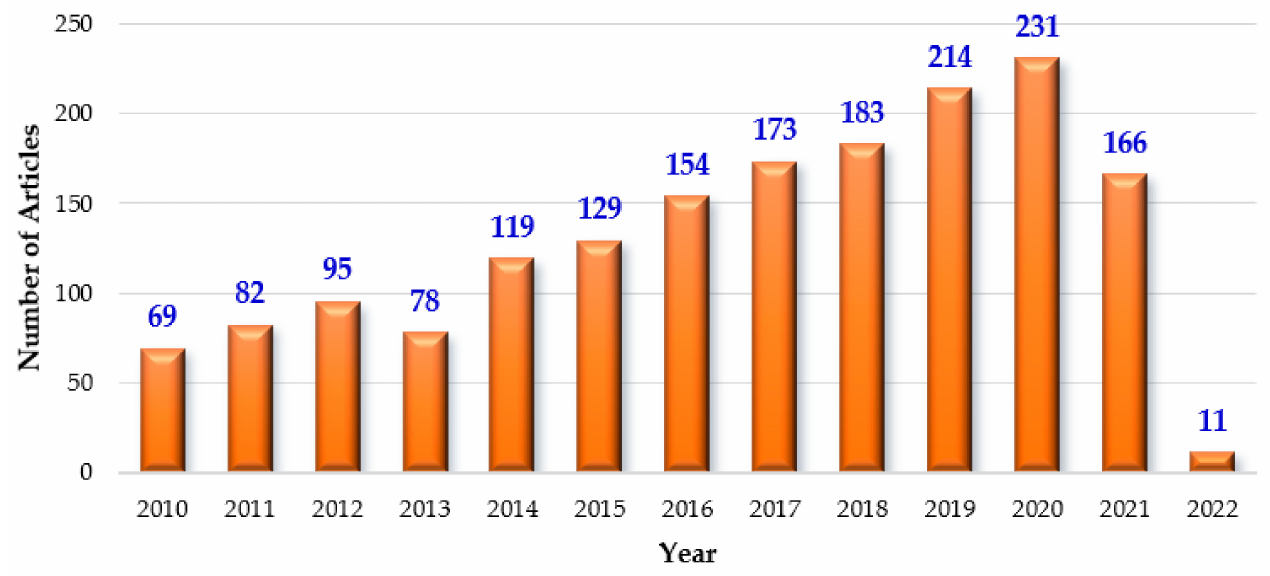
Figure 3. Conducted research works on the field of PEC integrated ESM for EV applications between 2010 and